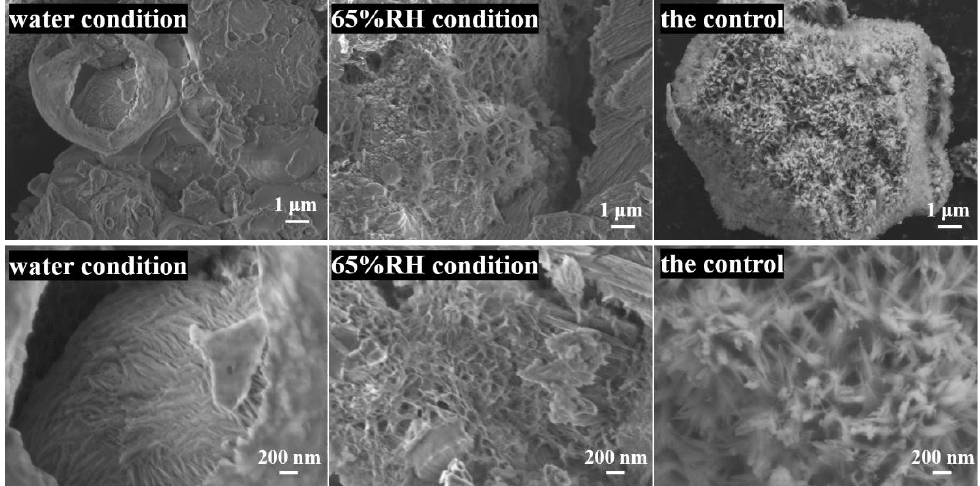
Figure 7. SEM images of hydration products under different conditions after 24 h. Table 1. EDX analysis of hydration products under different conditions after 24 h (at.%).